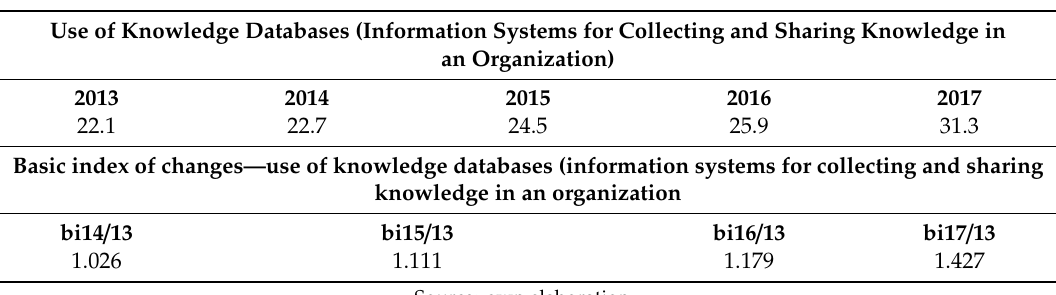
Table 8. Basic index of changes—use of knowledge databases (information systems for collecting and sharing knowledge in an